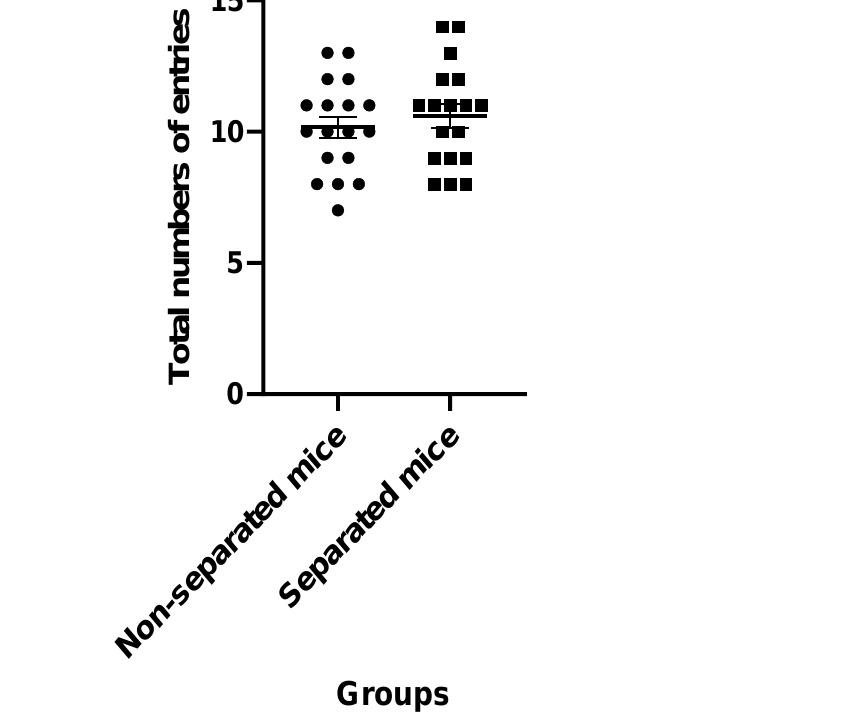
Figure 4. Total arm entries in the EPM test. There was no significant difference between the groups ( p > 0.05) ( n = 18/each group).